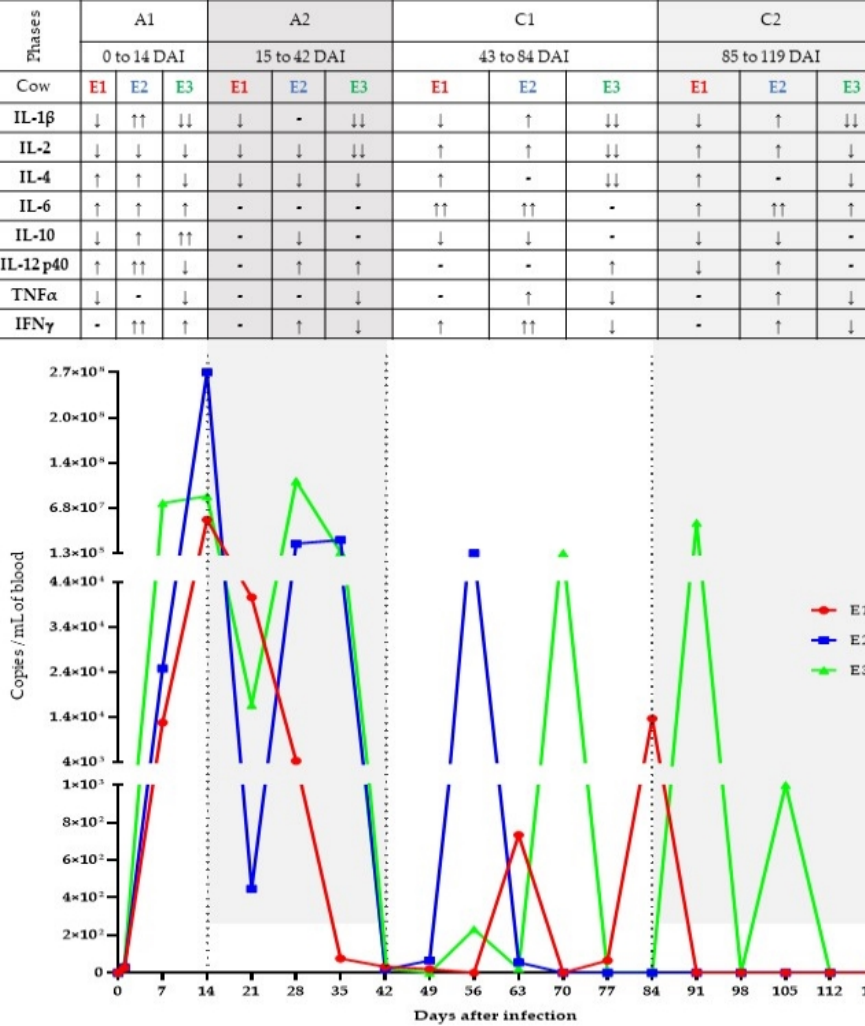
Figure 1. Parasitaemic curves quantified by qPCR (graphic) and cytokines profile (table) of three individual animals (E1, E2, and E3) experimentally infected by T. vivax : A1—Early patent phase, when an increase in parasitaemia was found (until an apparent peak); A2—Late patent phase, when a decrease of parasitaemia was found (apparent clearance of parasitaemia); C1—Early sub-patent phase, fluctuations/transient surges in parasitaemia; C2—Late sub-patent phase, absence of T. vivax DNA (except for animal E3 which did not control the infection). ↑ - increased; ↑↑ - huge increase; ↓ - decreased; ↓↓ - huge decrease.